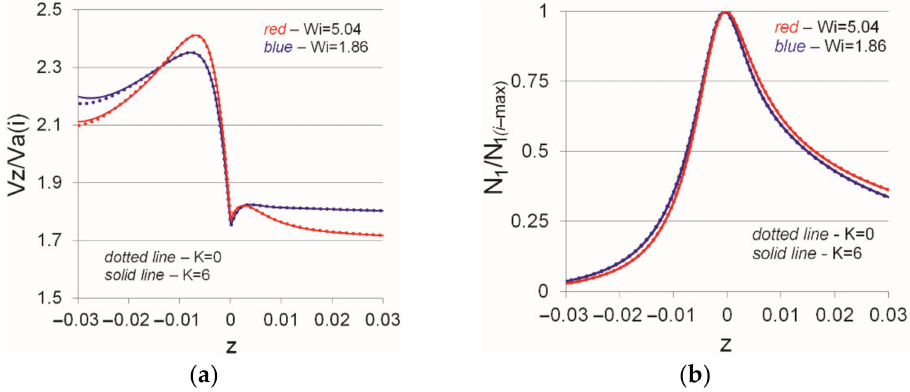
Figure 7. Normalized axial velocity ( a ) and first normal stress difference ( b ) along the centerline for various swirl intensities (K) and Weissenberg numbers